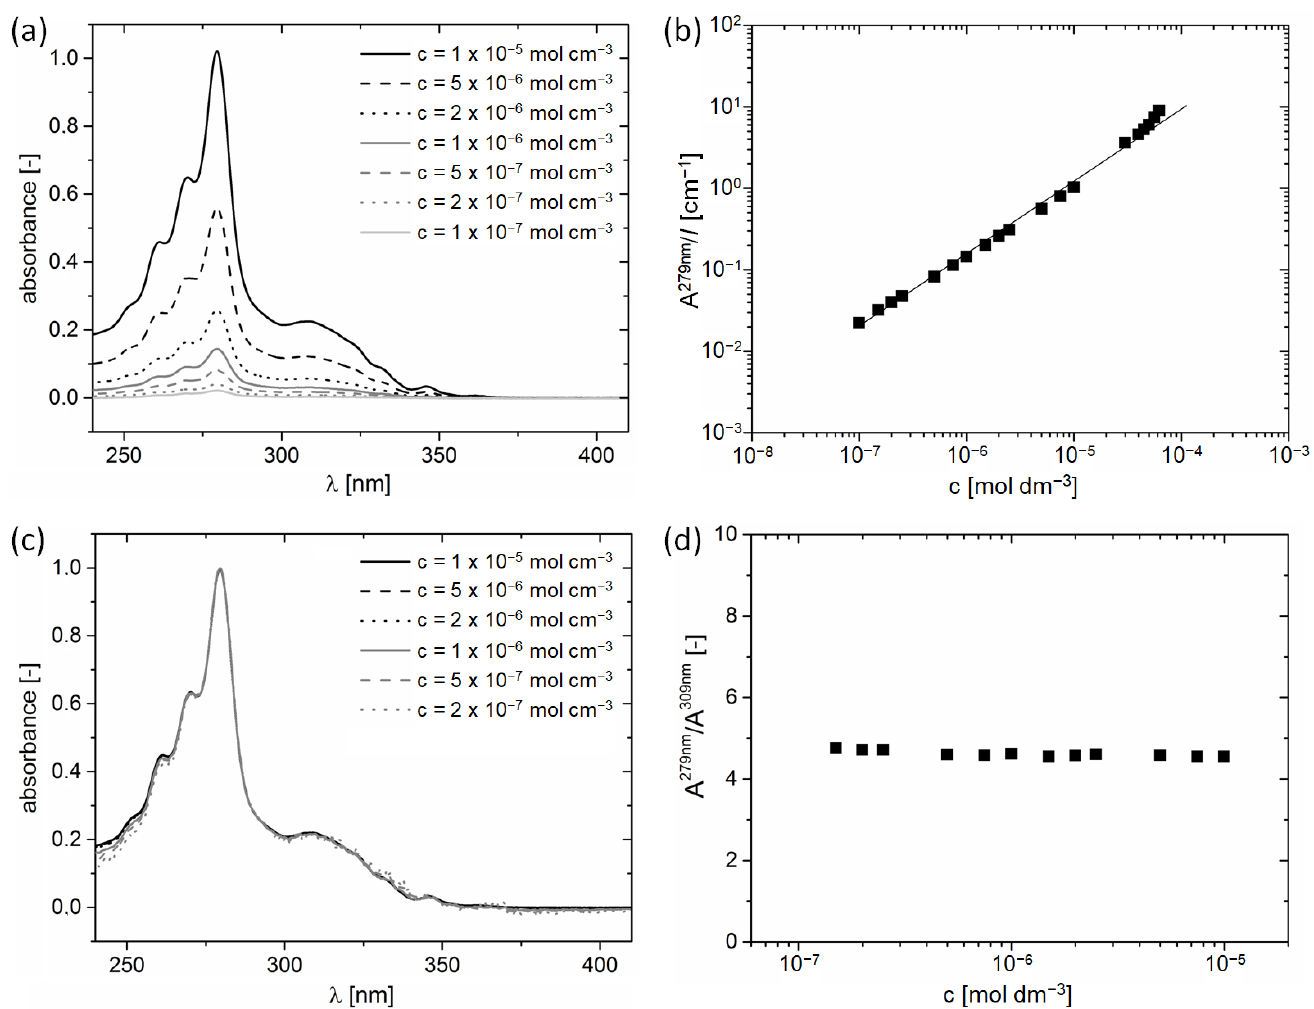
Figure 2. ( a ) UV-Vis absorption spectra of H5T in dichloromethane at 298 K in the range of concentrations 1 × 10 −5 mol dm −3 to 1 × 10 −7 mol dm −3 . ( b ) Absorbance at 279 nm/pathlength ( l ) as a function of the concentration of H5T in dichloromethane. ( c ) Normalized UV-Vis absorption spectra and ( d ) ratio of peak intensity of absorption maxima at 279 nm and 309 nm exhibiting a constant value.